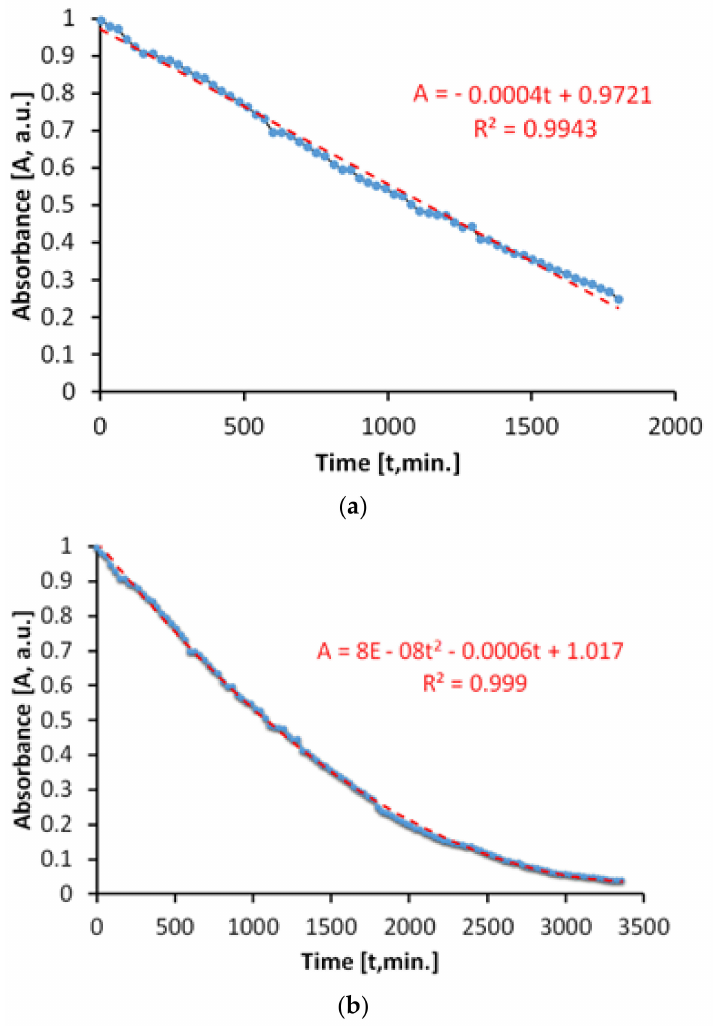
Figure 10. Time variation of MB absorbance upon irradiation exclusively with visible light in the presence of the photocatalytic paint; ( a ) linear domain; ( b ) until total discoloration.